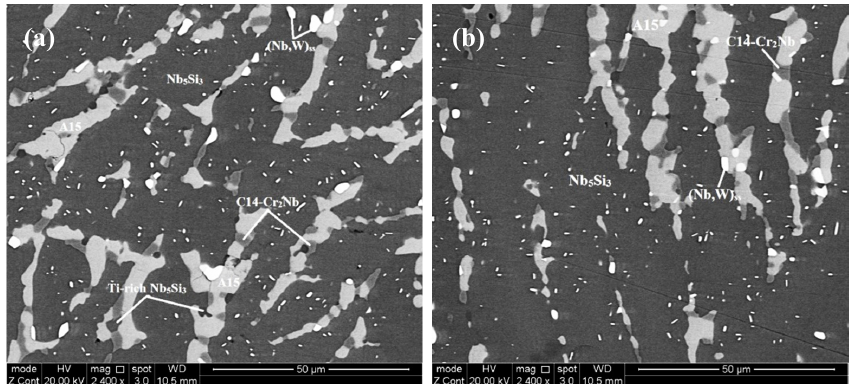
Figure 6. BSE images of the microstructure of the heat-treated alloy JZ3+ ( a ) in the bulk and ( b ) below the surface.